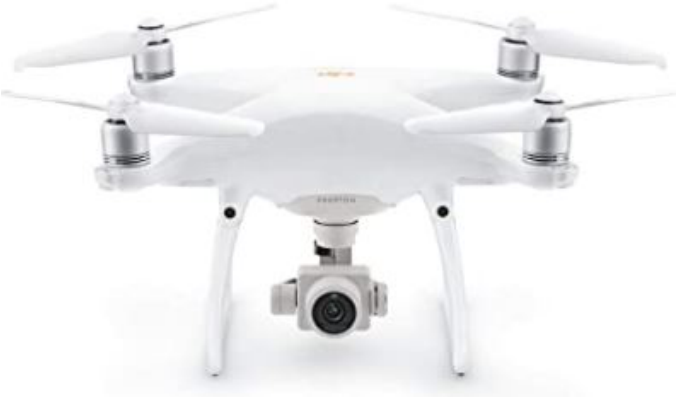
Figure 9. DJI Phantom 4 Pro drone.